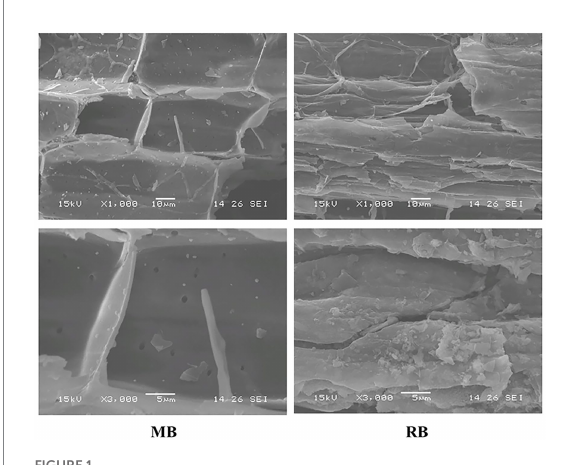
FIGURE 1 Surface morphology and structural characteristics of biochar observed by scanning electron microscopy (SEM; MB: maize straw biochar; RB: rice straw